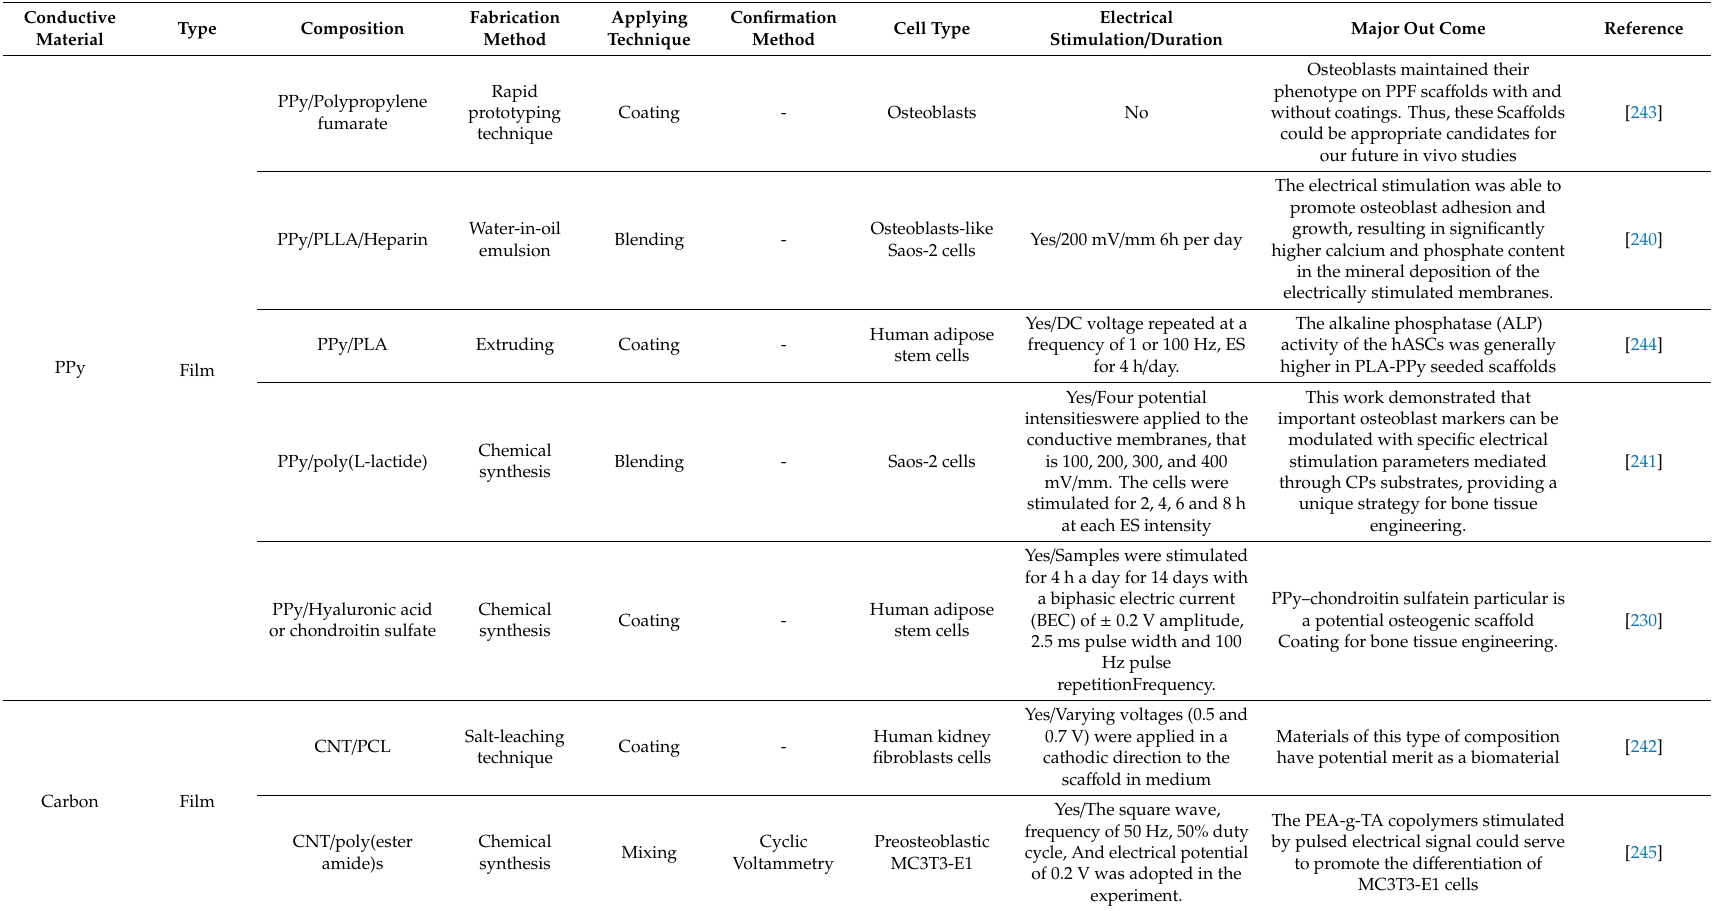
Table 4. Conductive sca ff olds used in bone tissue